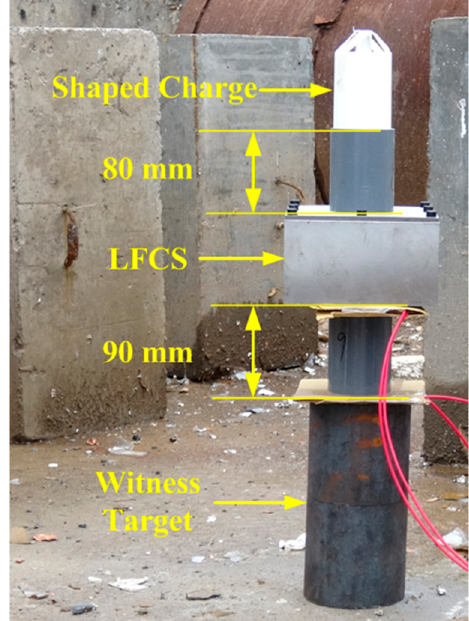
Figure 20. Field layout of the DOP experiment.